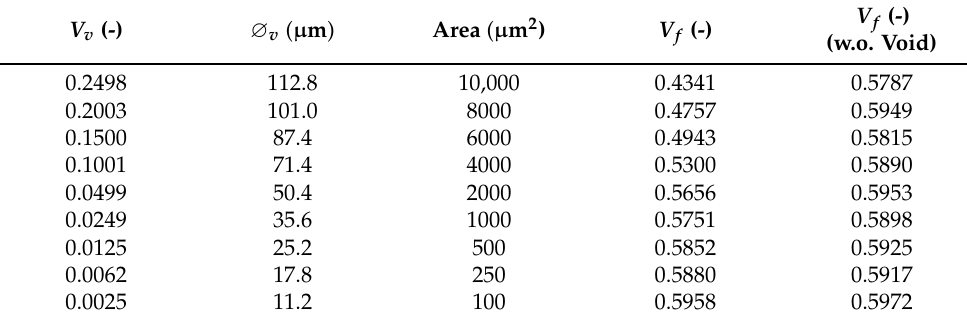
Table 2. V v of the RVEs with a circular void and the resulting V f .